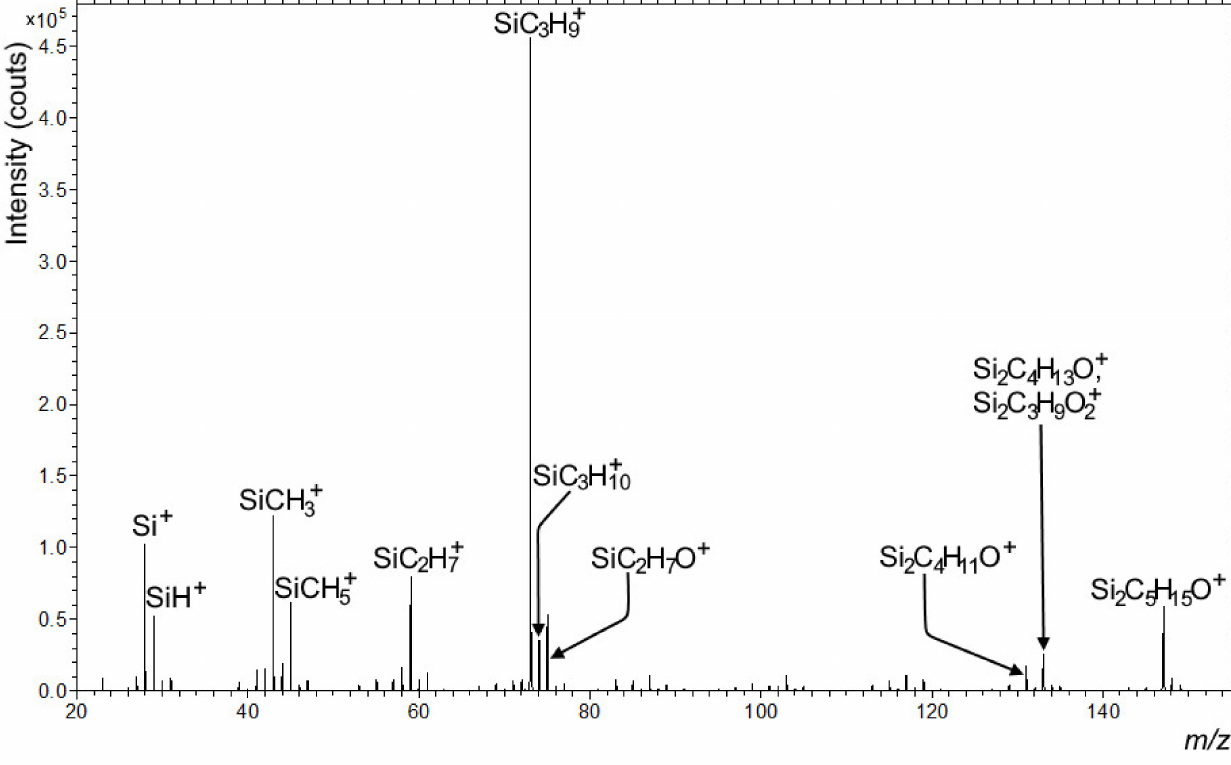
Figure 10. Positive secondary ion spectrum of the paper 2 coated with HMDSO in industrial plasma reactor in the m/z range from 20 to